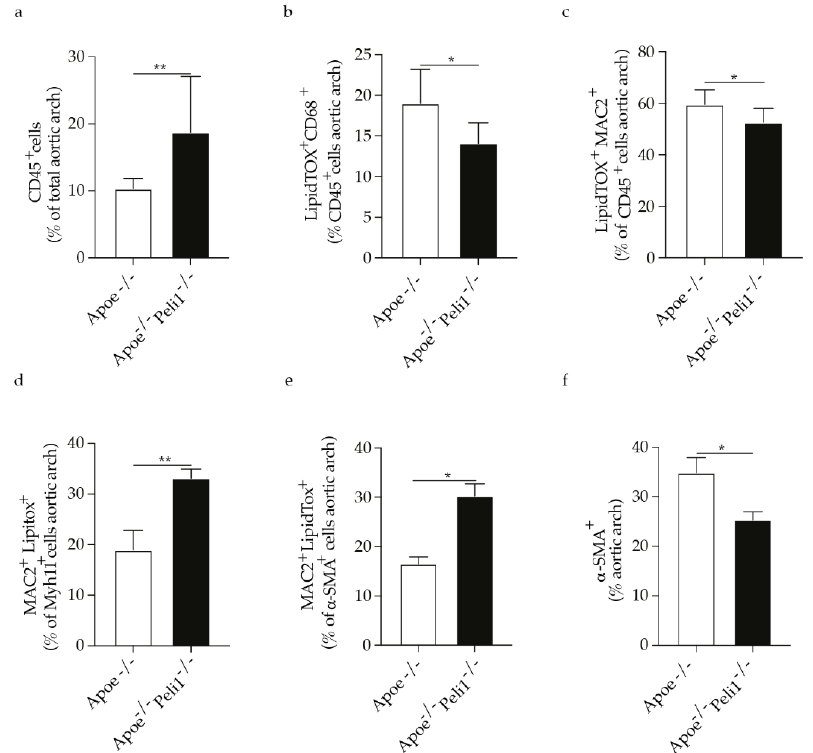
Figure 2. Bar graphs represent the quantification of aortic arch ( a ) total CD45 + cells in the aortic arch; ( b ) LipidTOX + CD68 + cells as a percentage of CD45 + cells; ( c ) LipidTOX + MAC2 + cells as a percentage of CD45 + cells; ( d ) MAC2 + LipidTOX + cells as a percentage of Myh11 + (VSMCs) cell; ( e ) MAC2 + LipidTOX + cells as a percentage of α -SMA + (VSMCs) cells and ( f ) total α -SMA + (VSMCs) cells in the aortic arch of Apoe − / − and Apoe − / − Peli1 − / − mice on HCD, with n =